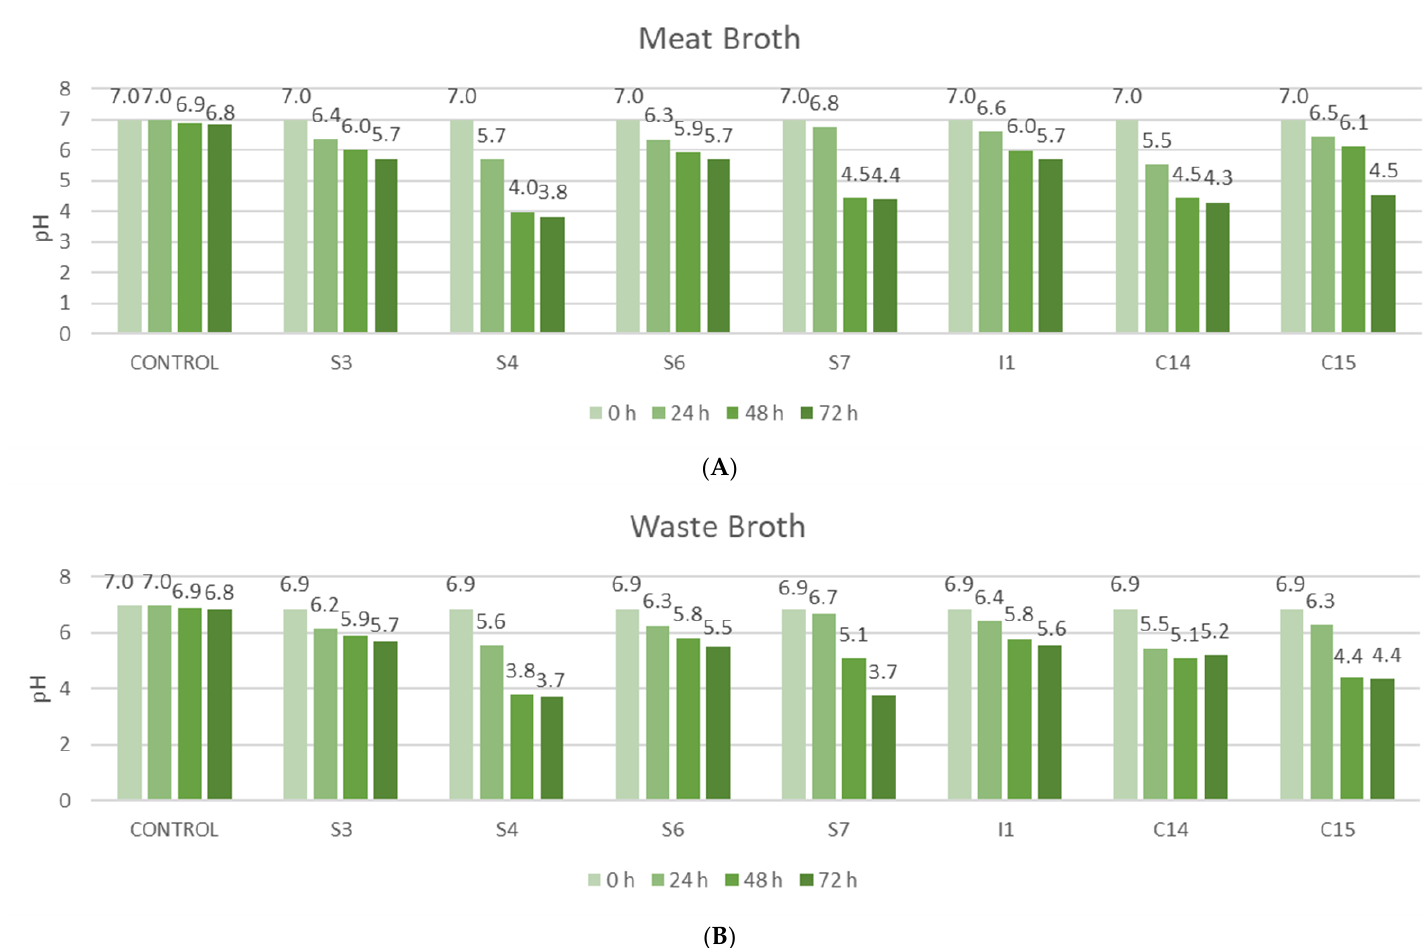
Figure 3. pH values of ( A ) meat broth (MB) and ( B ) by-products broth (WB) at three fermentation times (24, 48 and 72 h). S: Bacteria from stomach; I: Bacteria from small intestine; C: Bacteria from colon.